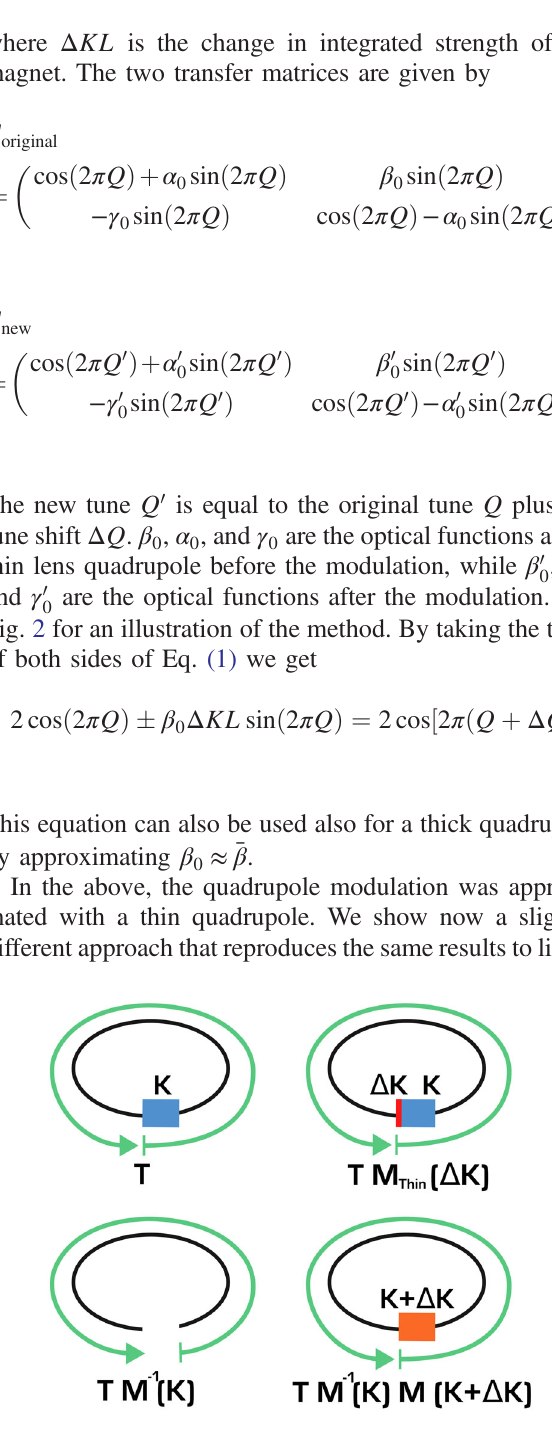
FIG. 2. Illustration of a one turn matrix (top left), and a one turn matrix with a thin quadrupole perturbation Δ K (top right). Below is a one turn matrix where a quadrupole of strength K is removed (bottom left), and a one turn matrix where a quadrupole of strength K has been replaced by a quadrupole of strength K þ Δ K (bottom